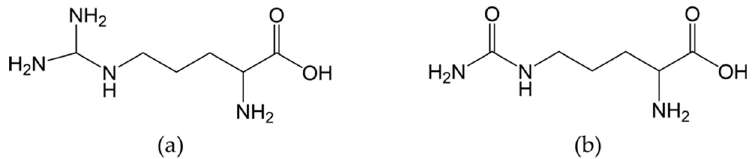
Figure 2. Chemical structure of ( a ) l -arginine and ( b ) l -citrulline.